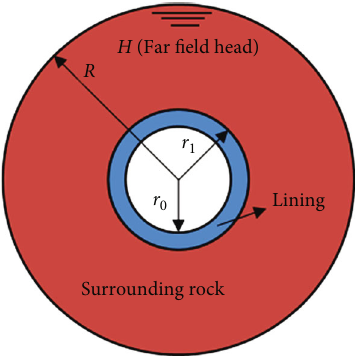
Figure 1: Tunnel seepage